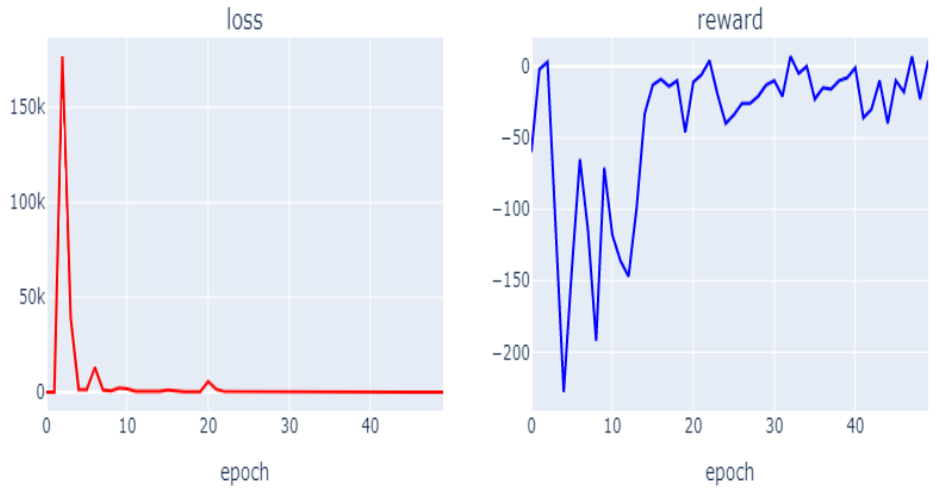
Figure 12. Learning results by substituting the Dueling DQN algorithm based on the proposed Total Resource on Apple.